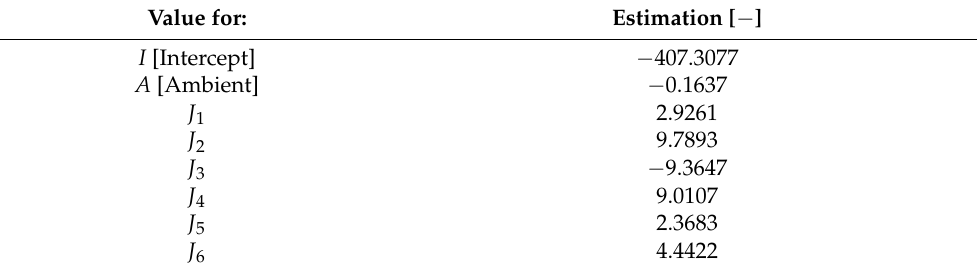
Table 2. Regression coefficients.